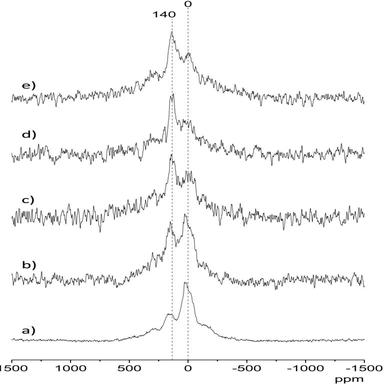
71Ga solid state MAS NMR spectra of hydrated Ga2O3 (a), Ga-impregnated (b), Ga-148 (c), Ga-74 (d) and Ga-37 (e).